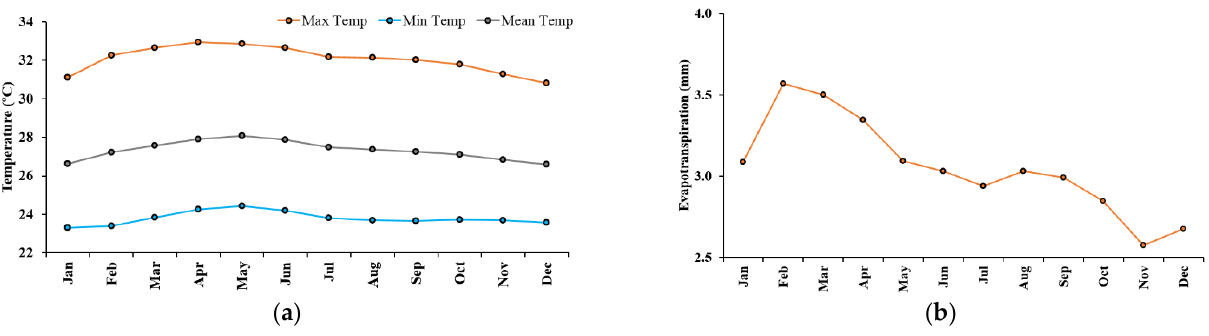
Figure 2. Variability in monthly average ( a ) daily maximum, mean, and minimum temperatures; ( b ) evapotranspiration in the study area from 1975 to 2014.